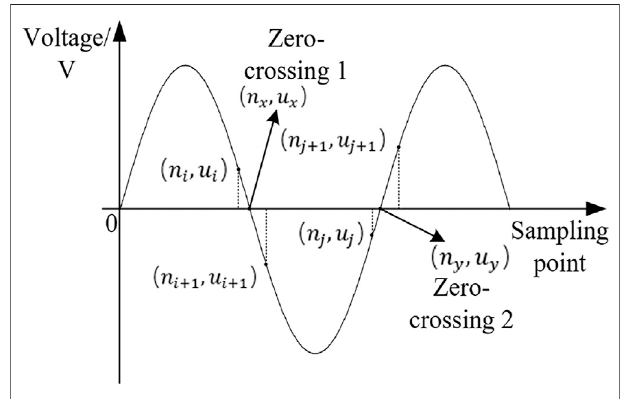
FIGURE 4 | Schematic diagram of zero-crossing